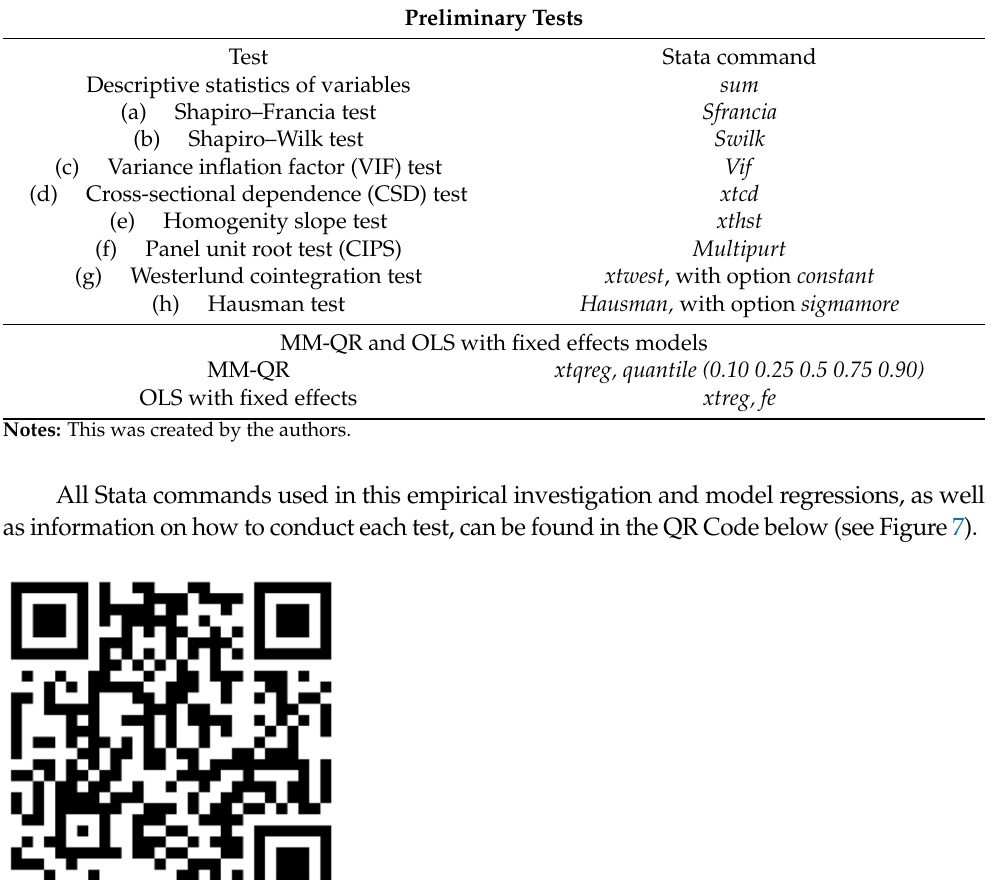
Table 3. Descriptive statistics of variables.